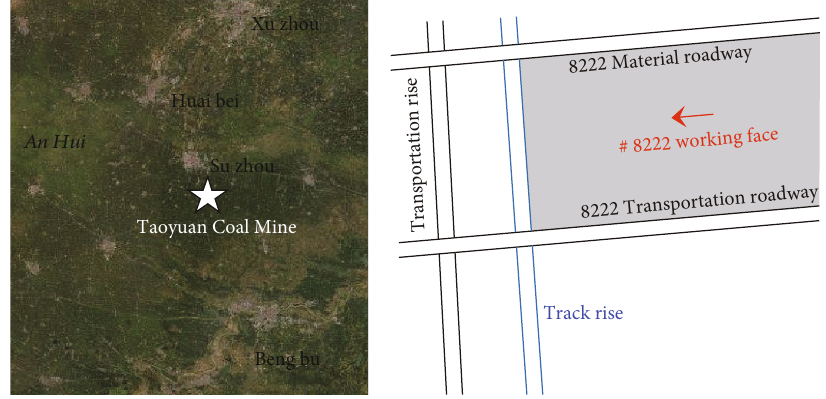
Figure 1: Location of the Taoyuan coal mine and the plane graph of mining face